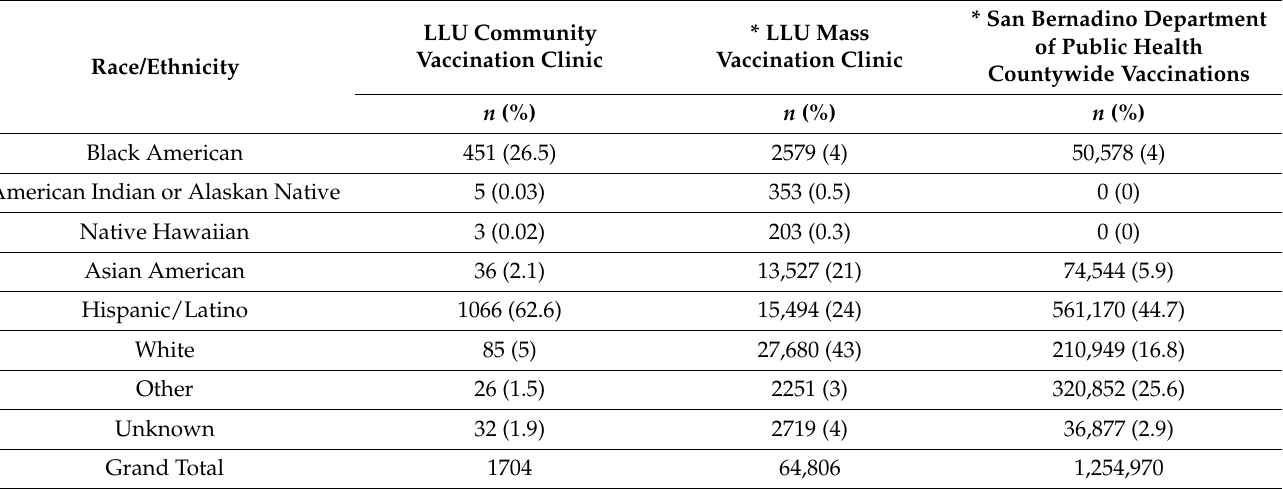
Table 3. Race/ethnicity demographics of LLU Community Vaccination Clinics compared to the LLU Mass Vaccination Clinic and the San Bernardino Countywide vaccination efforts